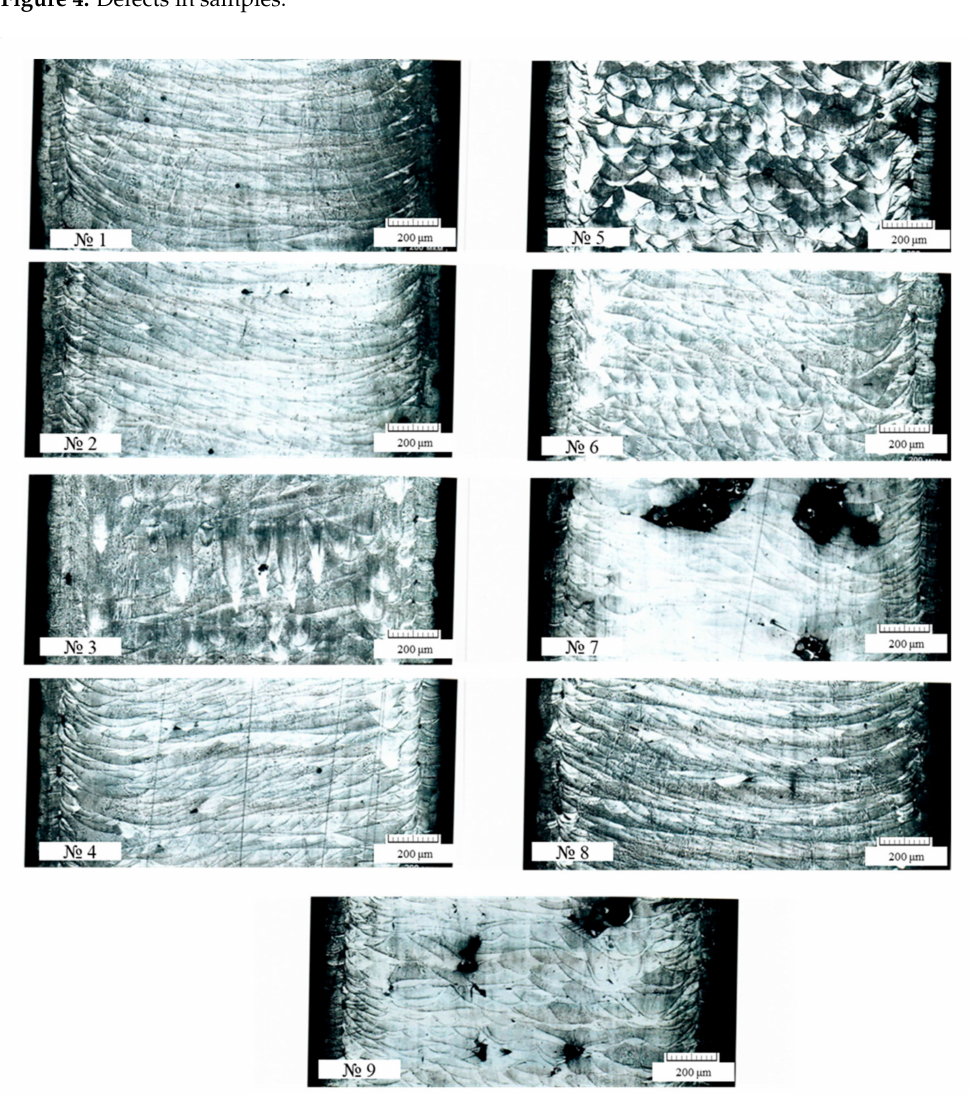
Figure 5. Cross-section comparison of 9 different types of melt pool geometries